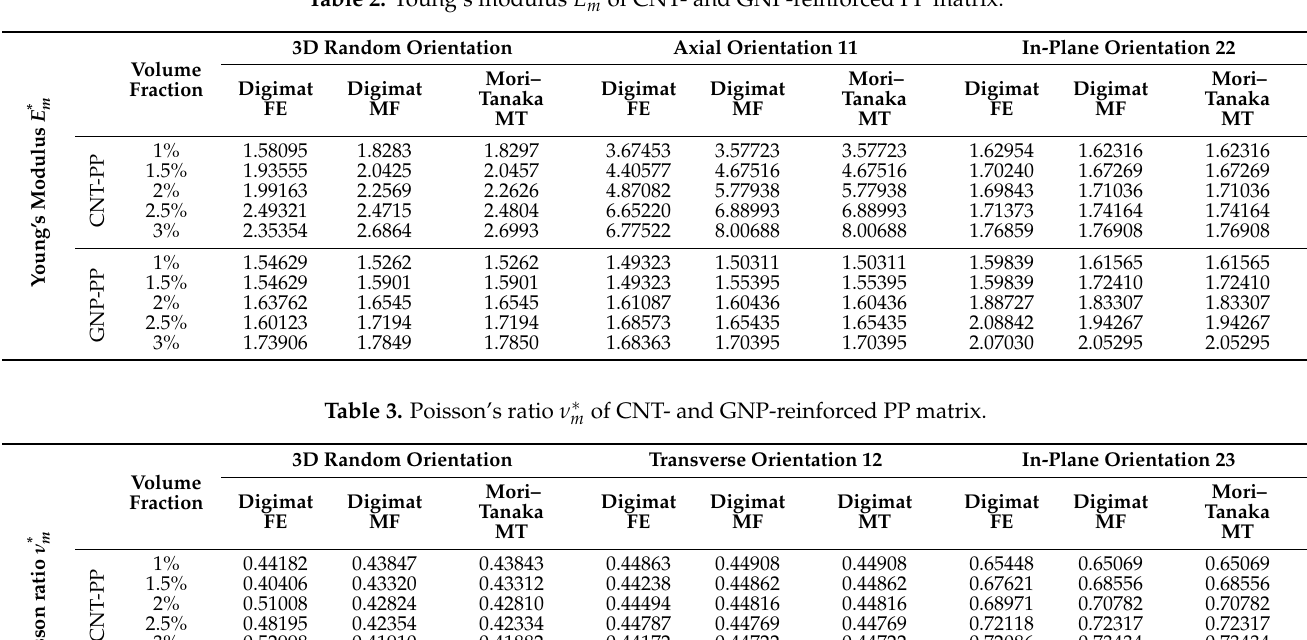
Figure 6. Effective elastic moduli of polymer reinforced by aligned and randomly oriented nanofillers, a comparison between Digimat-FE/MF and Mori–Tanaka approach. ( a ) CNT reinforced PP matrix. ( b ) GNP reinforced PP matrix. Table 2. Young’s modulus E ∗ m of CNT- and GNP-reinforced PP matrix.